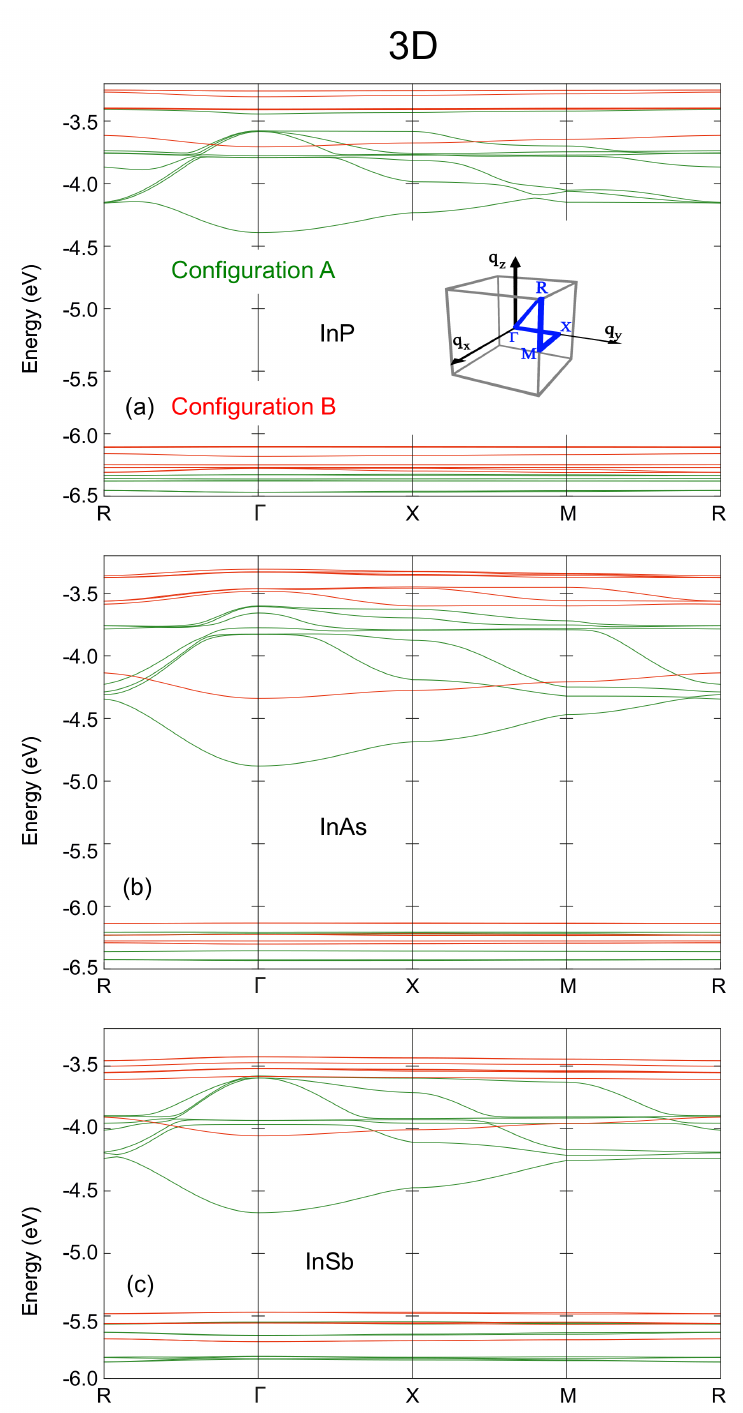
Figure 4. Miniband structure for 3D arrays of ( a ) InP, ( b ) InAs, and ( c ) InSb QDs with anion-rich (configuration A, green lines) and cation-rich (configuration B, red lines) surfaces. The energies on the vertical axis are relative to the vacuum level; the horizontal axis sweeps the Brillouin zone. The inset in ( a ) shows a schematic view of the path along the Brillouin zone together with the indexing of its major